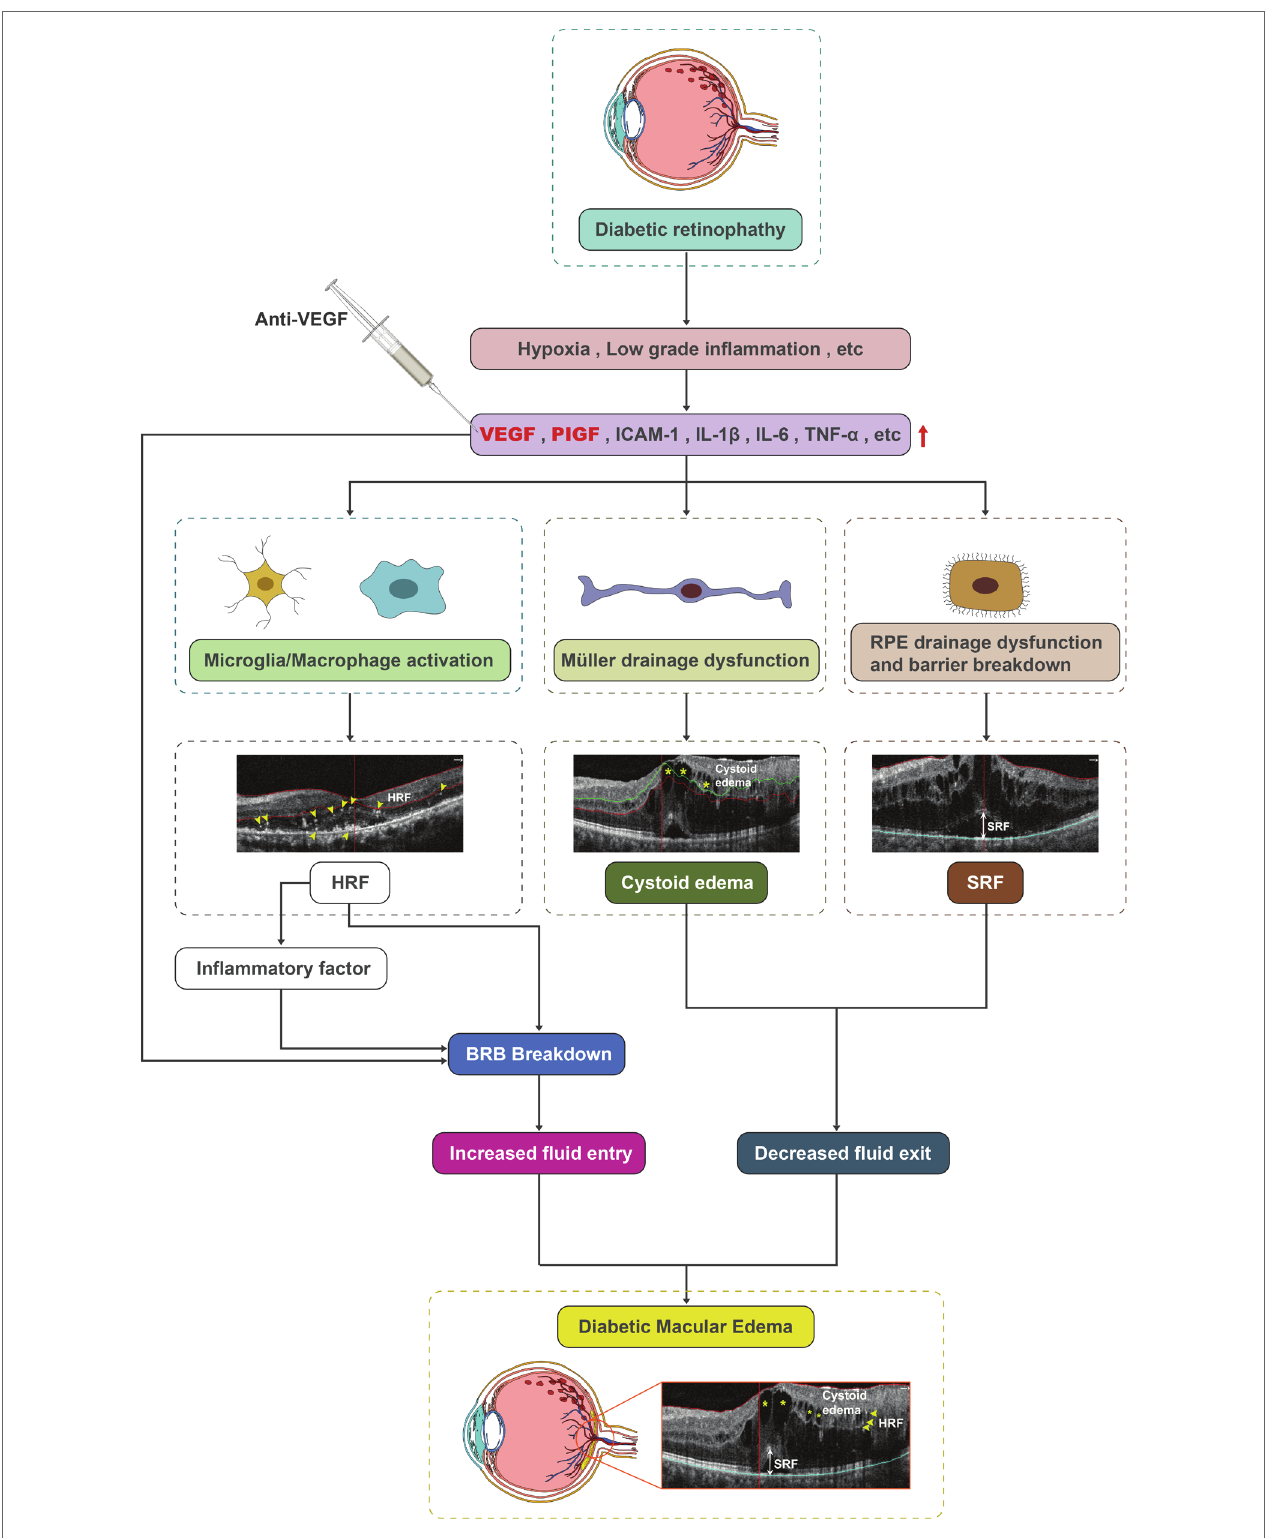
FIGURE 7 | Schematic diagram depicting microglia/macrophage activation, the drainage dysfunction of RMG and RPE, and barrier breakdown as contributors to DME. Aflibercept could improve drainage function in RMG and RPE by decreasing cystoid edema and SRF, and repress inflammatory cells by decreasing HRF. DME, diabetic macular edema; HRF, hyperreflective foci; RMG, retinal Müller glia; RPE, retinal pigment epithelium; and SRF, subretinal